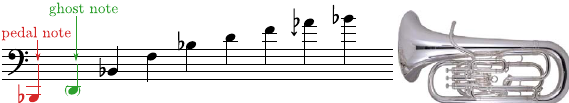
Figure 9. Natural notes playable by a euphonium, i.e. without depressing any valves. From left to right: B [ 1 (pedal note, red), D2 (ghost note, green), B [ 2, F3, B [ 3, D4, F4, A [ 4 (naturally a bit fl at compared to an equal tempered scale), B [